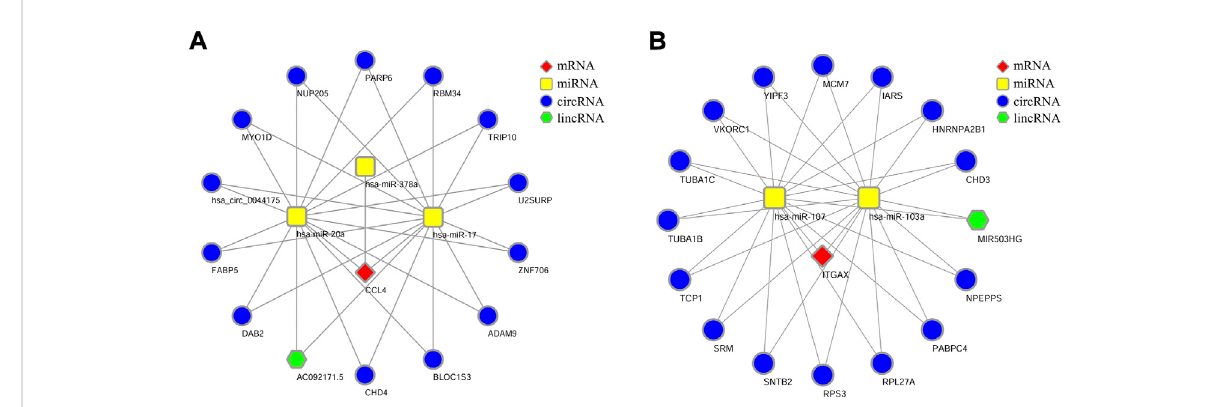
FIGURE 7 lncRNA/circRNA-miRNA-mRNA-ceRNAnetwork. (A) NetworkofCCL4-IncRNA-miRNA-mRNA. (B) NetworkofITGAX-IncRNA-miRNA-mRNA.